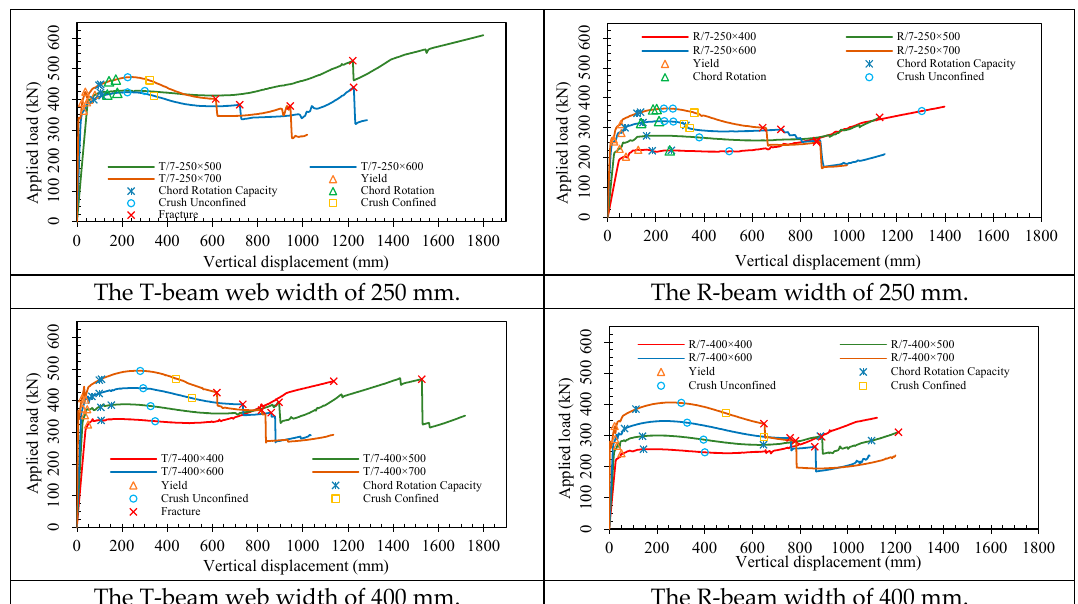
The T-beam web width of 400 mm. The R-beam width of 400 mm. Figure 4. Load-displacement relations of the different sub-assemblage designs.